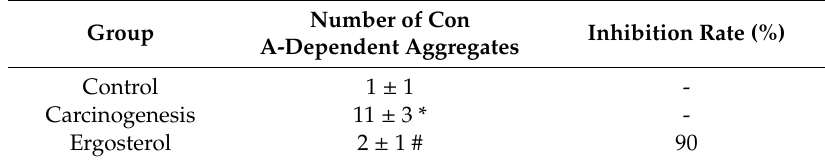
Table 2. Inhibitory effect of ergosterol on bladder carcinogenesis. Group